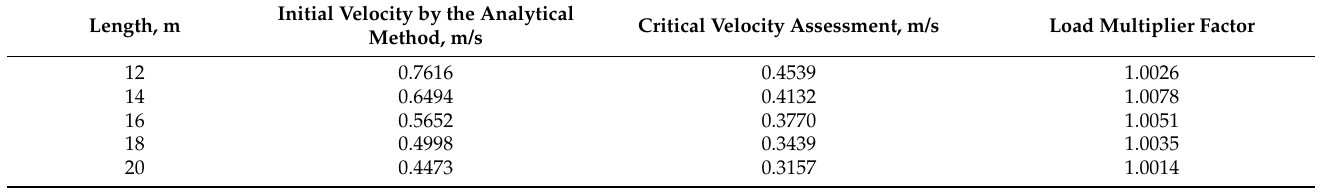
Table 8. The effect of pipe length (and width) on the critical velocity, for the Holding State.